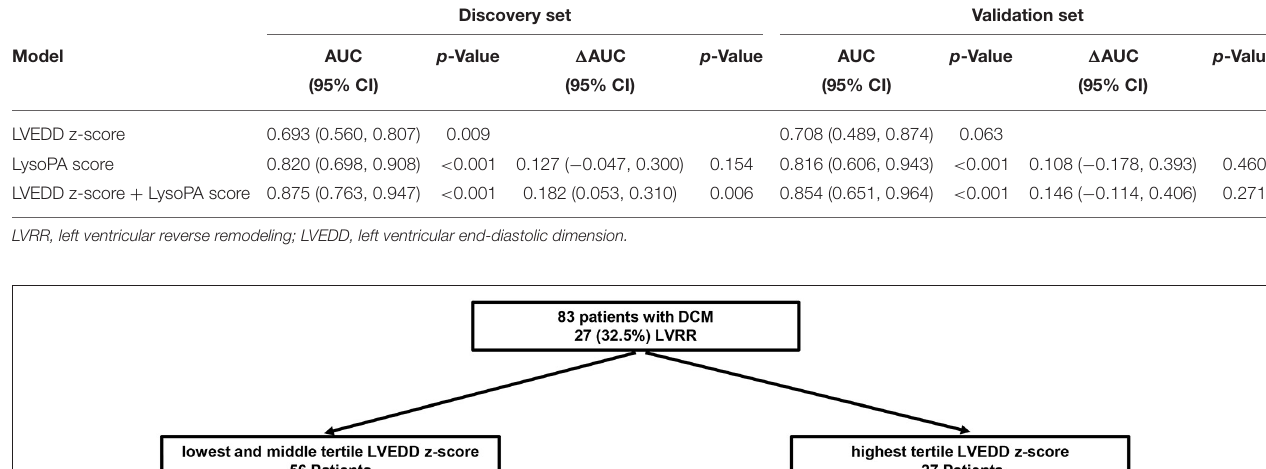
TABLE 4 | Prediction of LysoPA score and LVEDD z-score for LVRR in the discovery set and validation set. Discovery set